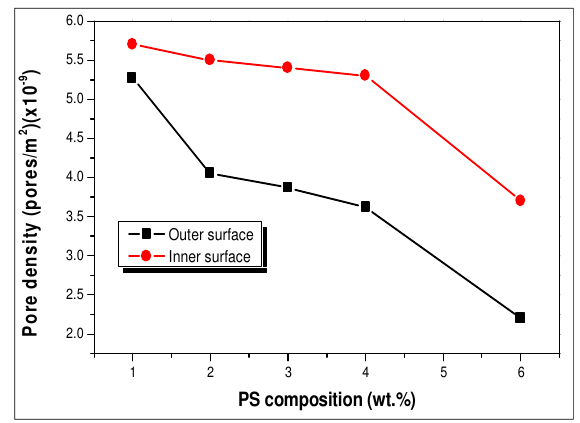
Fig. 4. Effect of PS compositions on the pore density of the hollow fiber blend